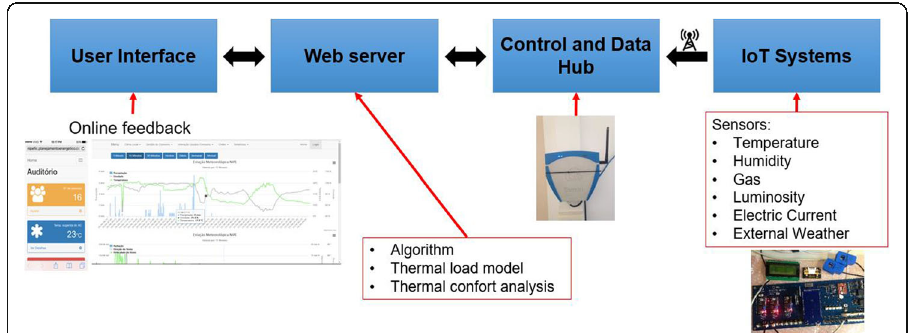
Fig. 5 Internet of Things for energy efficiency